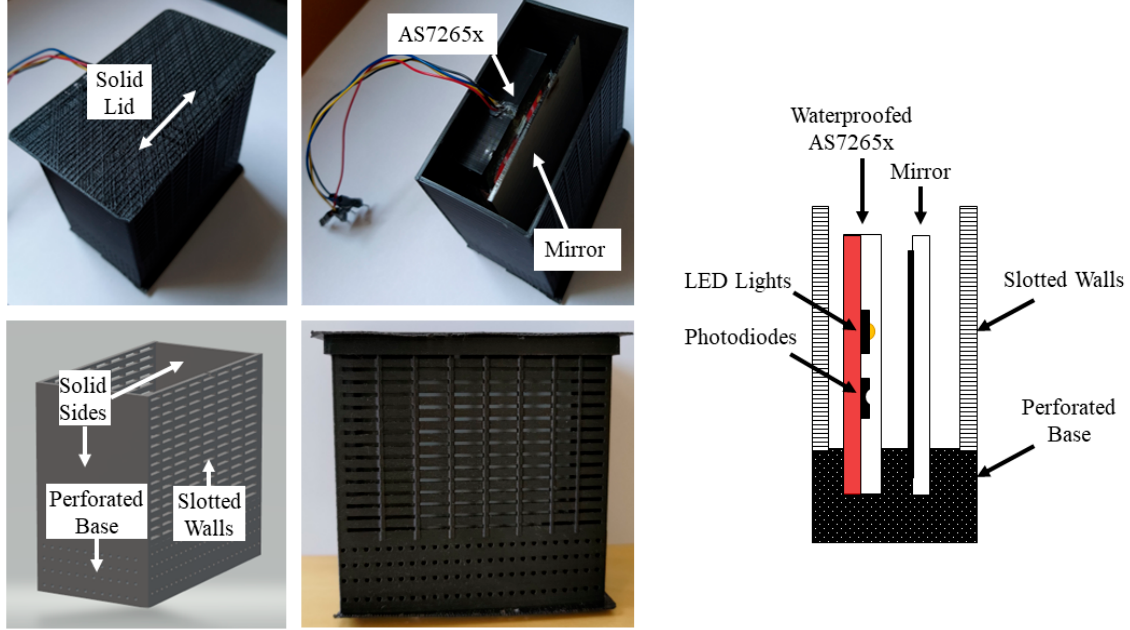
Figure 4. NutriSpec sensor printed housing, cross-section, and 3D diagram. Mirror and sensor were placed in special slots 5 mm apart inside the housing.